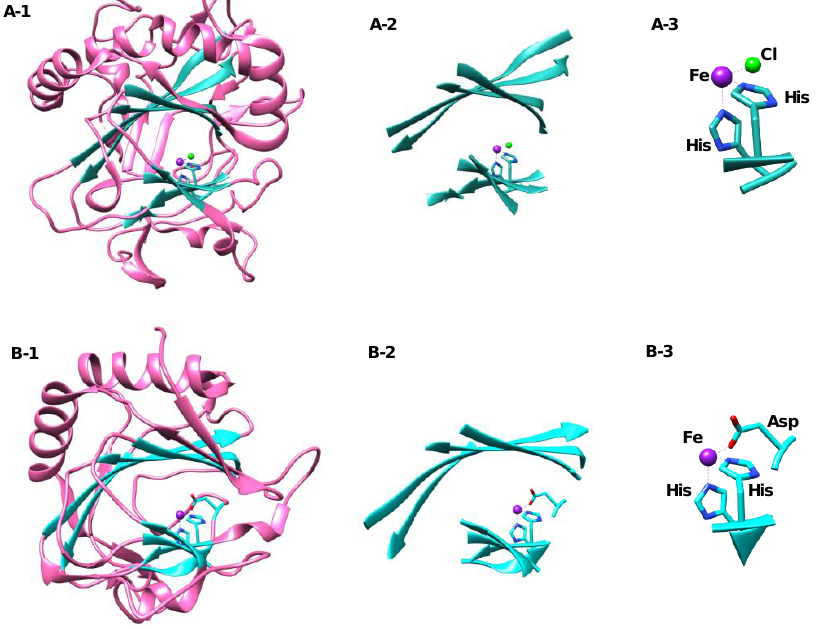
Figure 7. Basic components and comparison between the nonheme iron halogenase, SyrB2 ( A ) from Pseudomonas syringae (PDB 2FCT) and the nonheme iron hydroxylase, prolyl-4-hydroxylase ( B ) from Clamydomonas reinhardtii (PDB 2JIG). A-1 & B-1 show similarities in tertiary structure. A-2 &